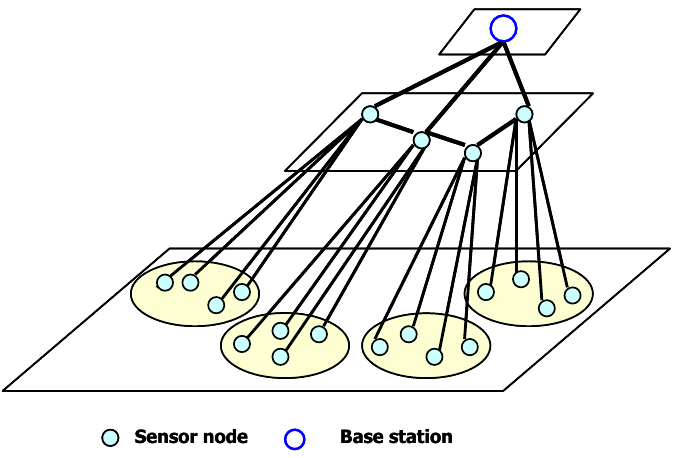
Figure 5. Hierarchical wireless sensor